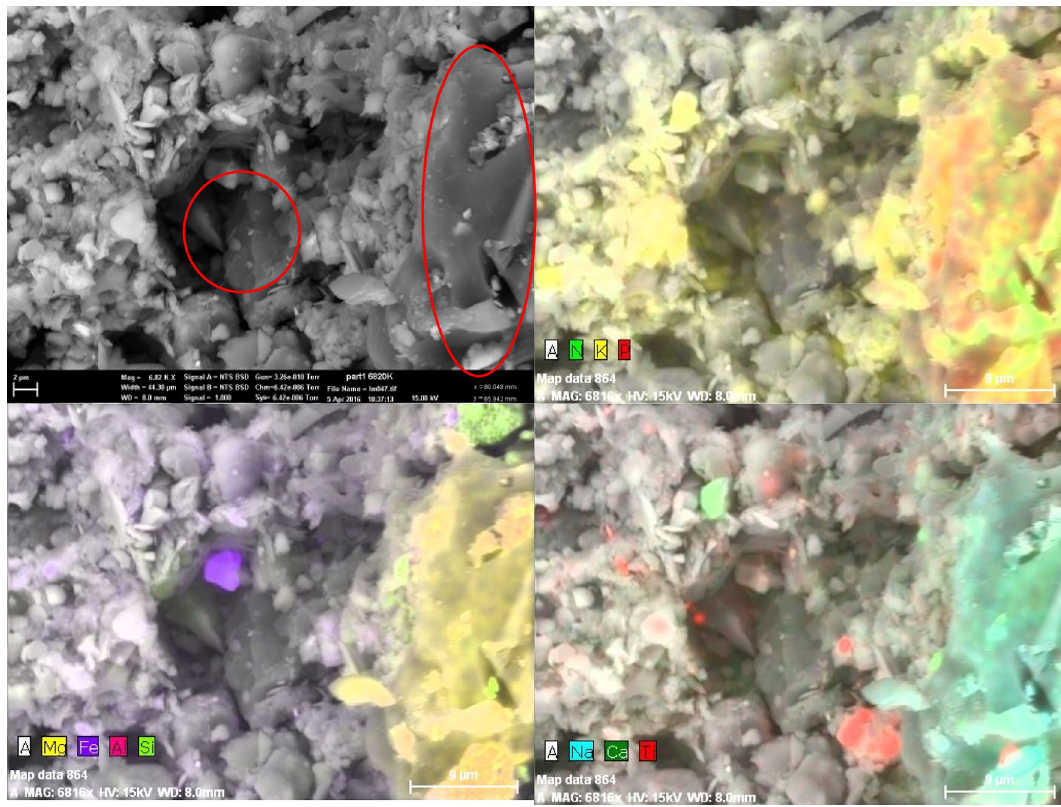
Figure 4. Secondary electron image of the surface of the aged biochar and EDS maps of this surface. Red circles indicate a biochar matrix that has a minerals’ coating on its internal pores and external